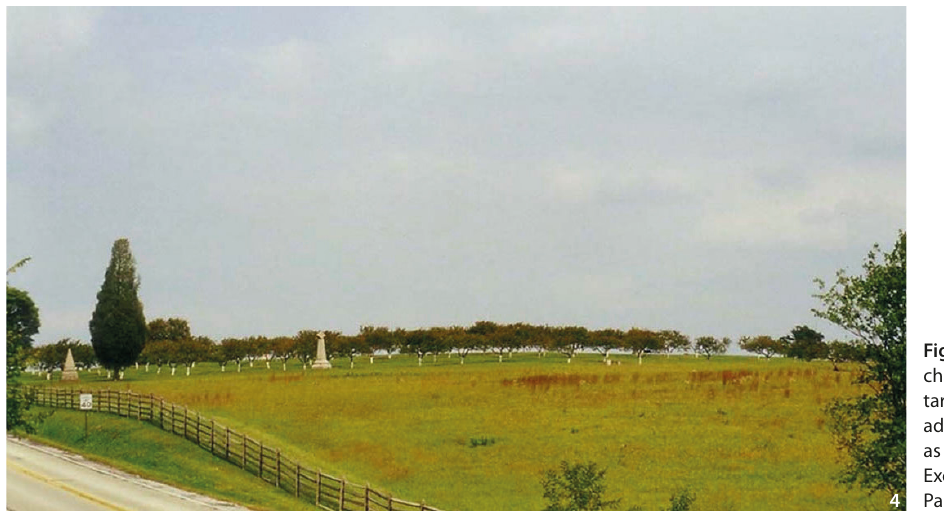
Figure 4 View of the Peach Or- chard, Gettysburg National Mili- tary Park, one of the many parks added to the National Park System as a result of a 1933 Presidential Executive Order (Source: National Park Service).